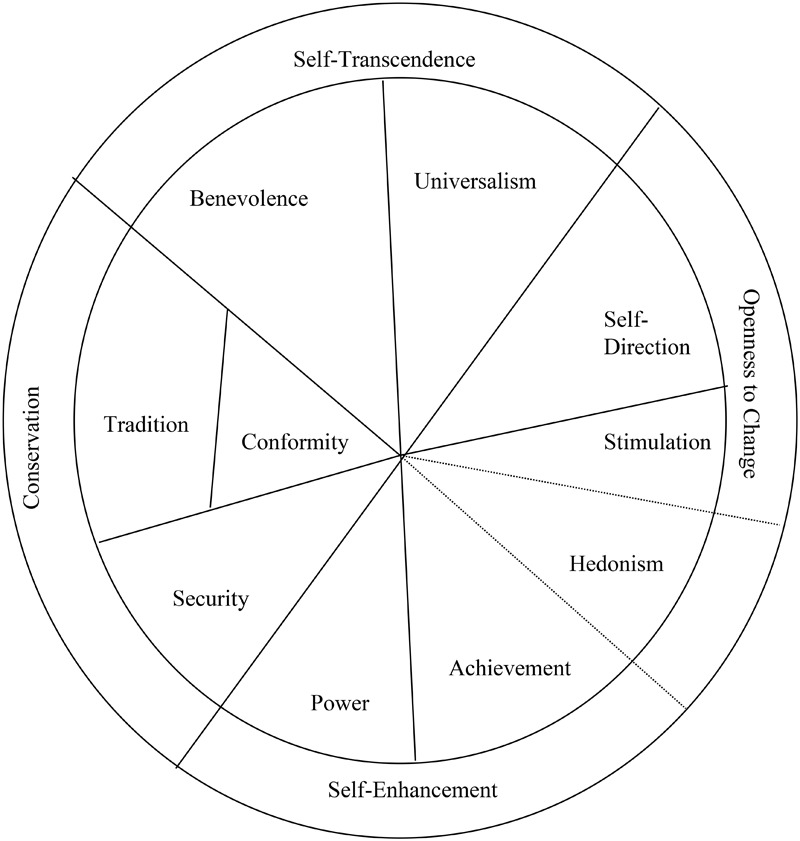
The structure of values (Schwartz, 1992).